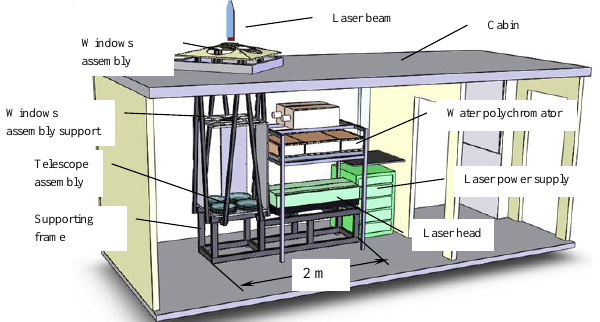
Fig. 2. Mechanical setup of the lidar: a support frame welded from square stainless steel tubing holds the telescope assembly, the laser head, and a protective window support; the lidar polychromator is mechanically separated from the telescopes using fiber coupling (not shown in the figure).